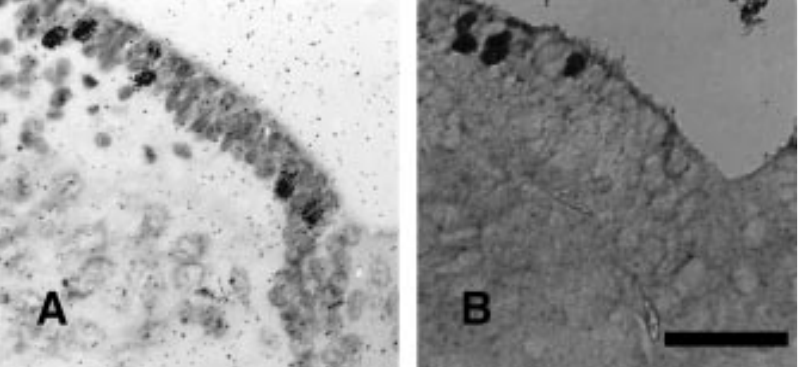
Figure 1 - A comparison of the identification of prolif- erating cells by [ 3 H]-T radioautography and by prolif- erating cell nuclear antigen (PCNA) immunohis- tochemistry. Photomicrographs of 10-µm adjacent coronal sections passing through the fourth ventricle (IVv) of an opossum aged 12 postnatal days (P12), that was killed 2 h after a single intraperitoneal injec- tion of [ 3 H]-T (10 µCi/g body weight). A, Dipping radioautogram obtained with Kodak NTB2 emulsion and counterstained with cresyl-violet. Observe cells containing silver grains in the ventricular/ subventricular zone of the IVv. B, Immunoreaction with an anti-PCNA monoclonal antibody (Sigma) us- ing the biotin-avidin-horseradish peroxidase method (Sigma kit). Magnification bar = 50